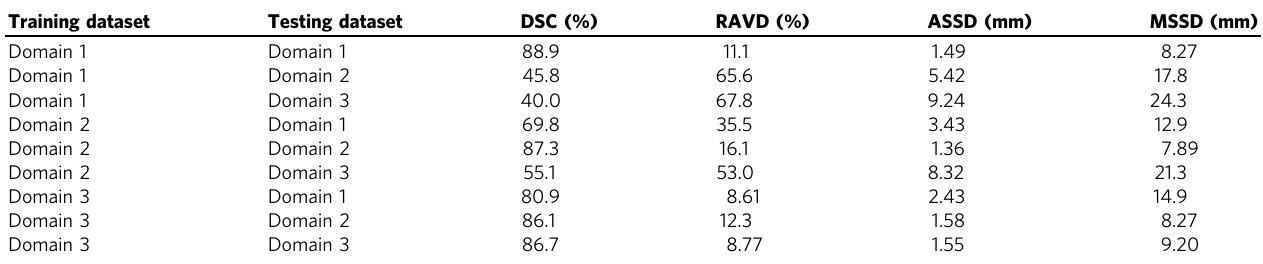
Table 2 Segmentation results of networks trained and tested with prostate datasets of different domains. Training